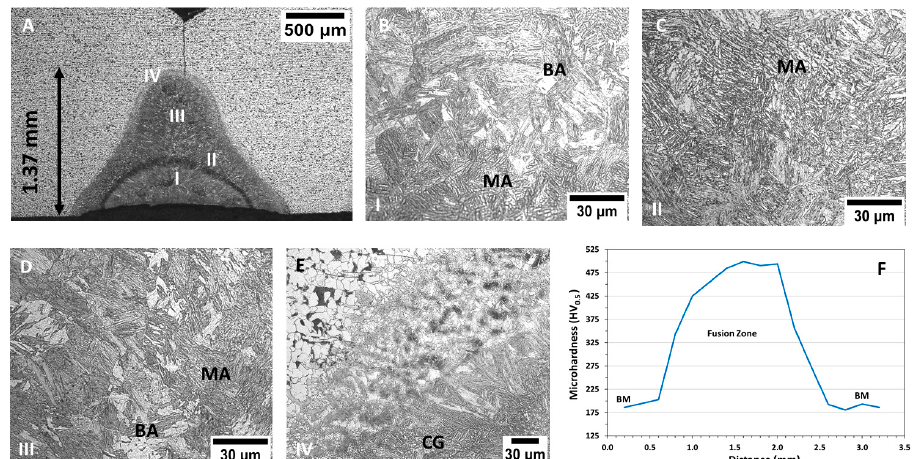
Figure 2. Macro- and micrographs showing the features and microstructures of the PL weld seam ( A – E ) and the microhardness profile ( F ). BA—Bainite, MA—Martensite, and CG—Columnar Grains.